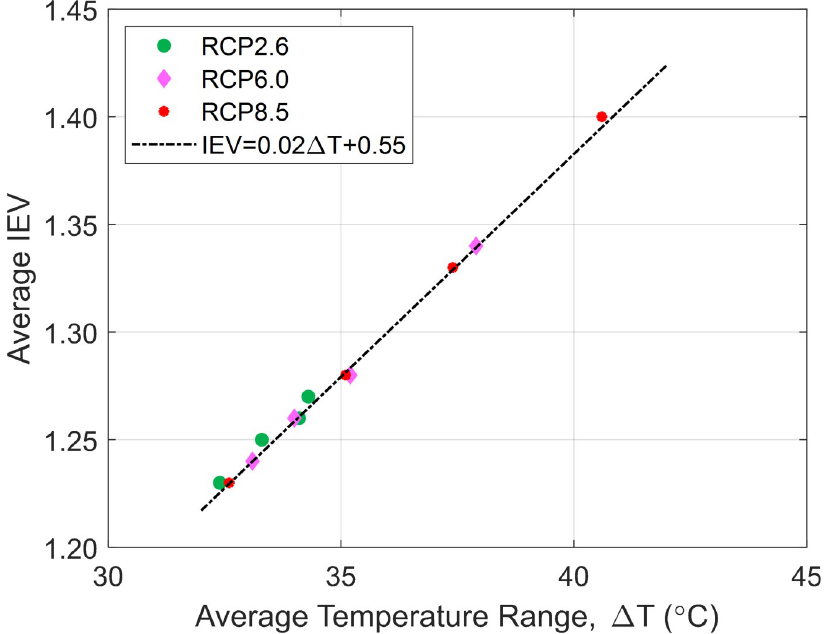
Fig 6. Average IEV as function of average temperature